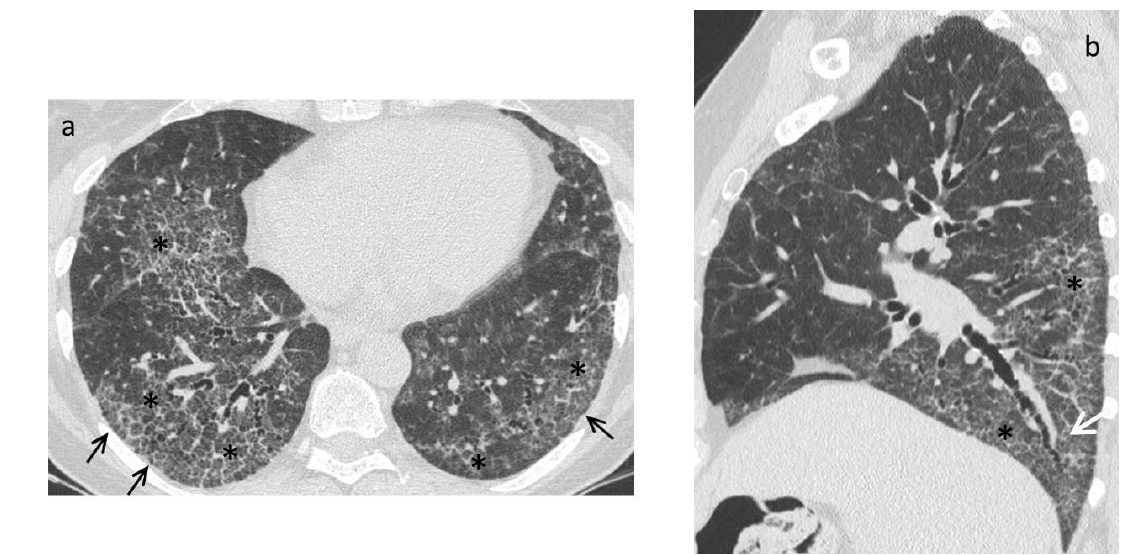
Figure 3. Late stage. High resolution CT images in axial ( a ) and sagittal ( b ) plane show a fibrotic nonspecific interstitial pneumonia (NSIP) pattern characterized by the presence of bilateral extensive ground glass opacities (*) with a peripheral and symmetric distribution with signs of fibrosis due to the presence of reticulations (black arrows) and traction bronchiectasis (white arrows).